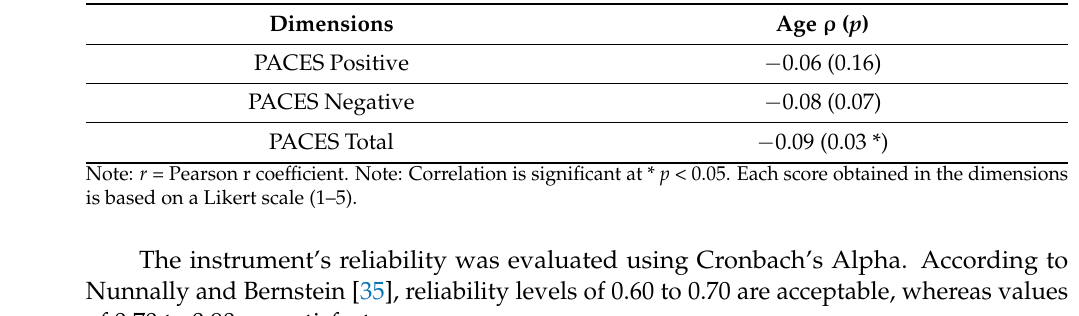
Table 4. Correlations between the dimensions and the age